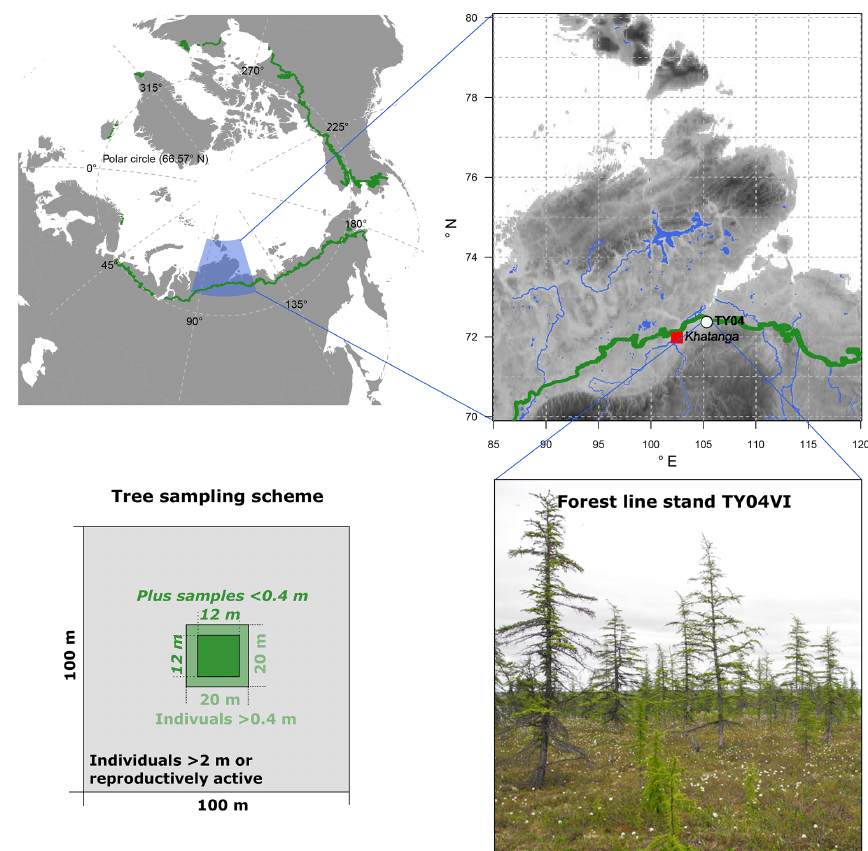
Figure 1. Overview of the larch forests ( Larix gmelinii ) growing at study site TY04VI on the southern Taymyr Peninsula and the sampling scheme. The green circumartic line on the maps marks the modern treeline (Walker et al., 2005). Topography in the enlarged area ranges between 1 and 2521m (WorldClim 1.4; Hijmans et al., 2005). Rivers and lakes are given in blue colours (GSSHS updated version 2.2.2, 1 January 2013, first published by Wessel and Smith, 1996). Photo is from Stefan Kruse (16 July